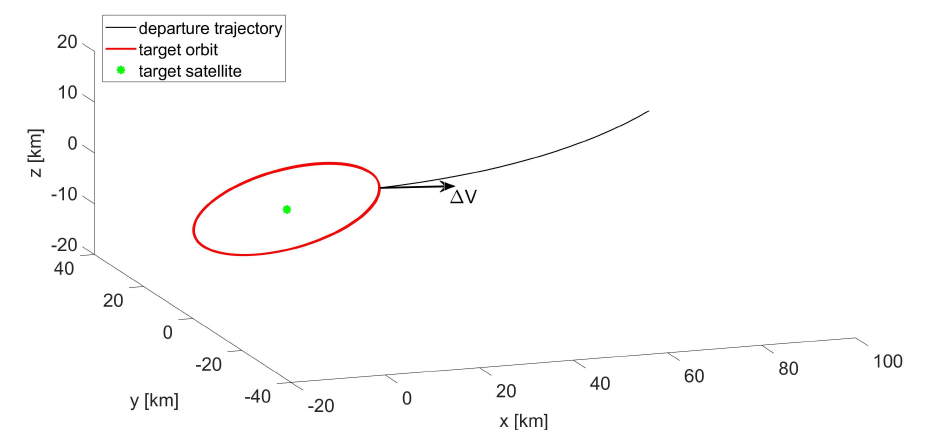
Figure 15. Guidance strategy: detail of the injection point between the departure trajectory and the target orbit in F r ; the arrow indicates the direction of the ∆ V provided.